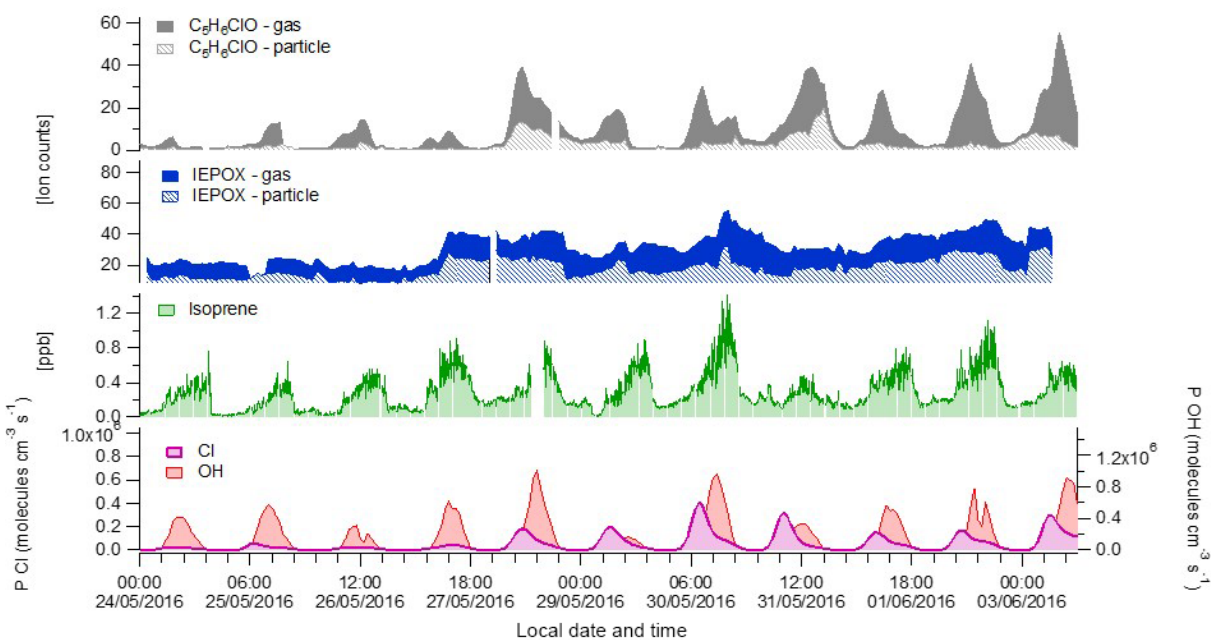
Figure 9. Campaign time series of isoprene, isoprene epoxydiol (IEPOX), CMBO and steady-state production rate of chlorine atoms and OH.